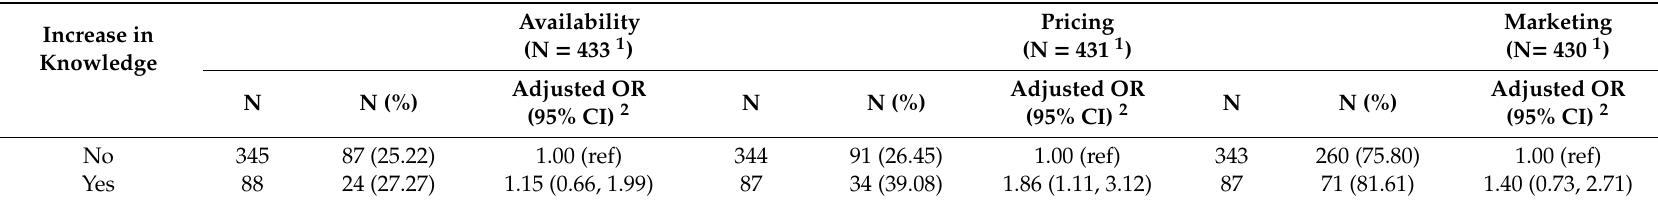
Table 3. Adjusted odds ratios (OR) and 95% confidence intervals (CI) of support for policy by increase in knowledge of alcohol as a